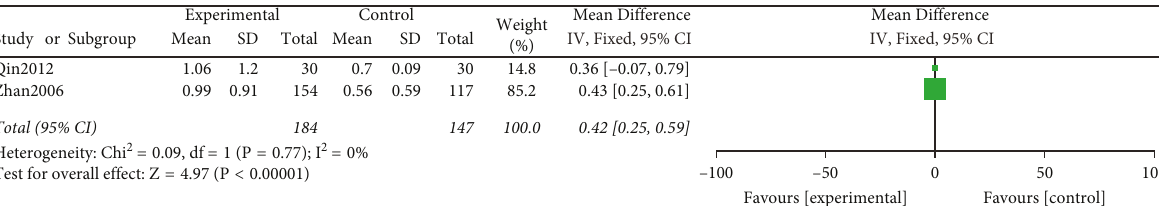
Figure 9: Comparison between the mean difference scores before and after treatment of symptom scores (viability) of manipulation and cervical traction in the treatment of